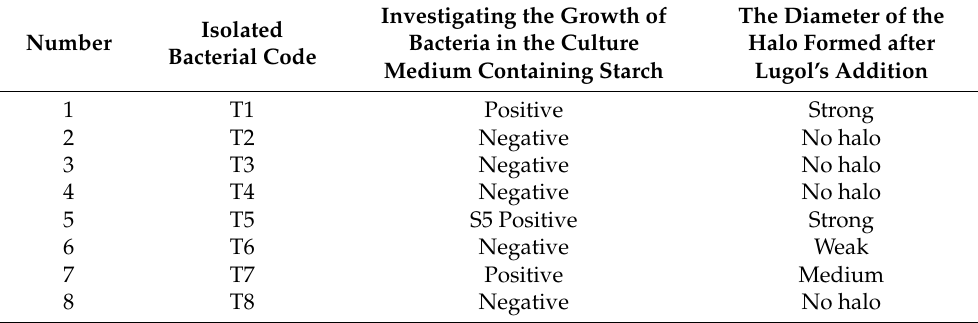
Figure 1. Pure culture of isolated bacteria in nutrient agar medium ( a ), growth of α -amylase-producing bacteria in a specific solid culture medium containing starch ( b ), and a clear halo around the colony of α -amylase-producing bacteria using Lugol’s solution ( c ). Table 1. Evaluation of bacterial strains capable of producing α -amylase from the intestines of Sillago sihama.